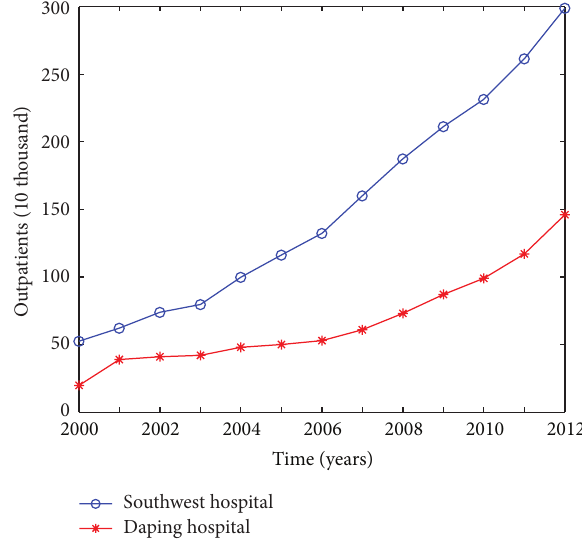
Figure 3: Illustration of the basic reproduction number for viral hepatitis and brothers mouth disease between the years of 2003 and 2012.